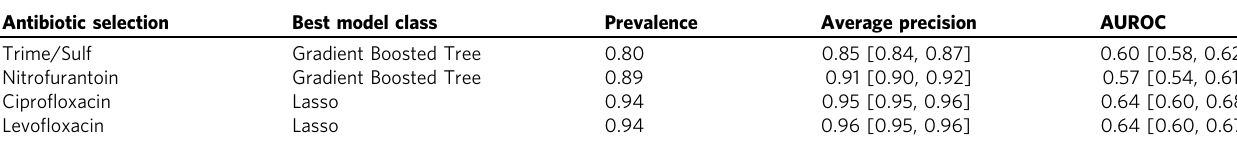
Table 4 Boston Model Performances.